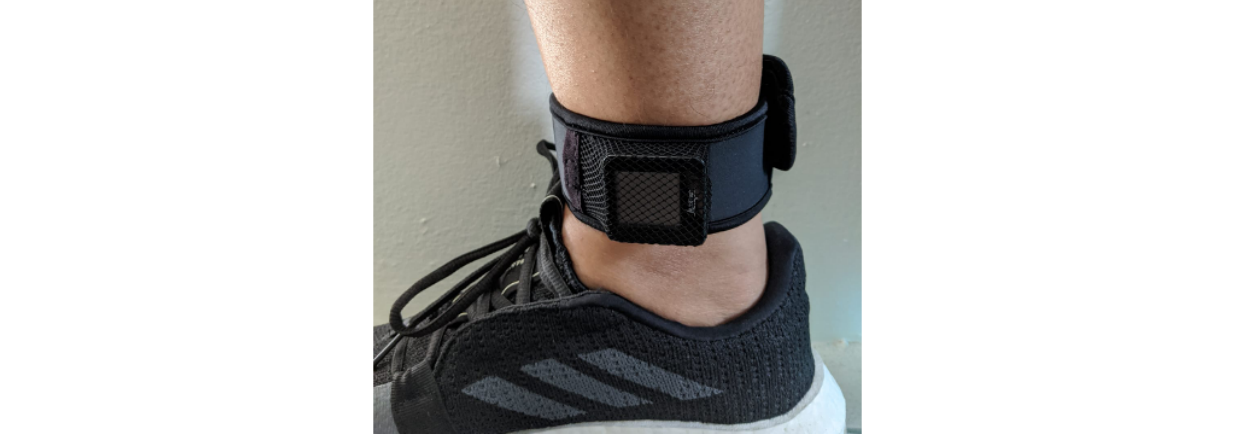
Figure 2. GT9X activity monitor worn on the dominant ankle.